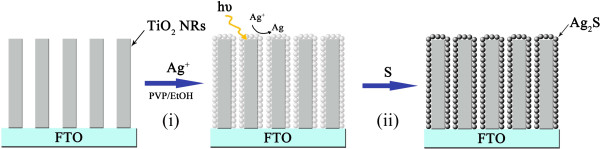
Schematic illustration of the deposition of Ag2S on TiO2 NRA. (i) Photoreduction of Ag+ to Ag; (ii) sulfurization.